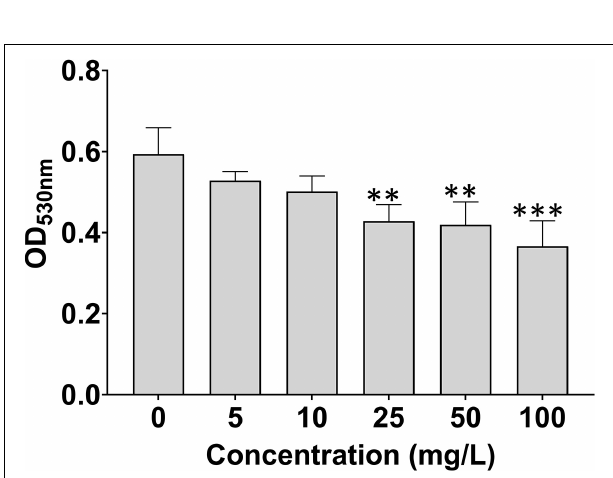
FIGURE 3 | Effects of 7-methoxycoumarin on biofilm formation of R. solanacearum . OD530 values were quantified after treatment with different concentrations of 7-methoxycoumarin at 30 ◦ C for 24 h in 96-well plates; ** indicates p < 0.01 and *** indicates p < 0.001).